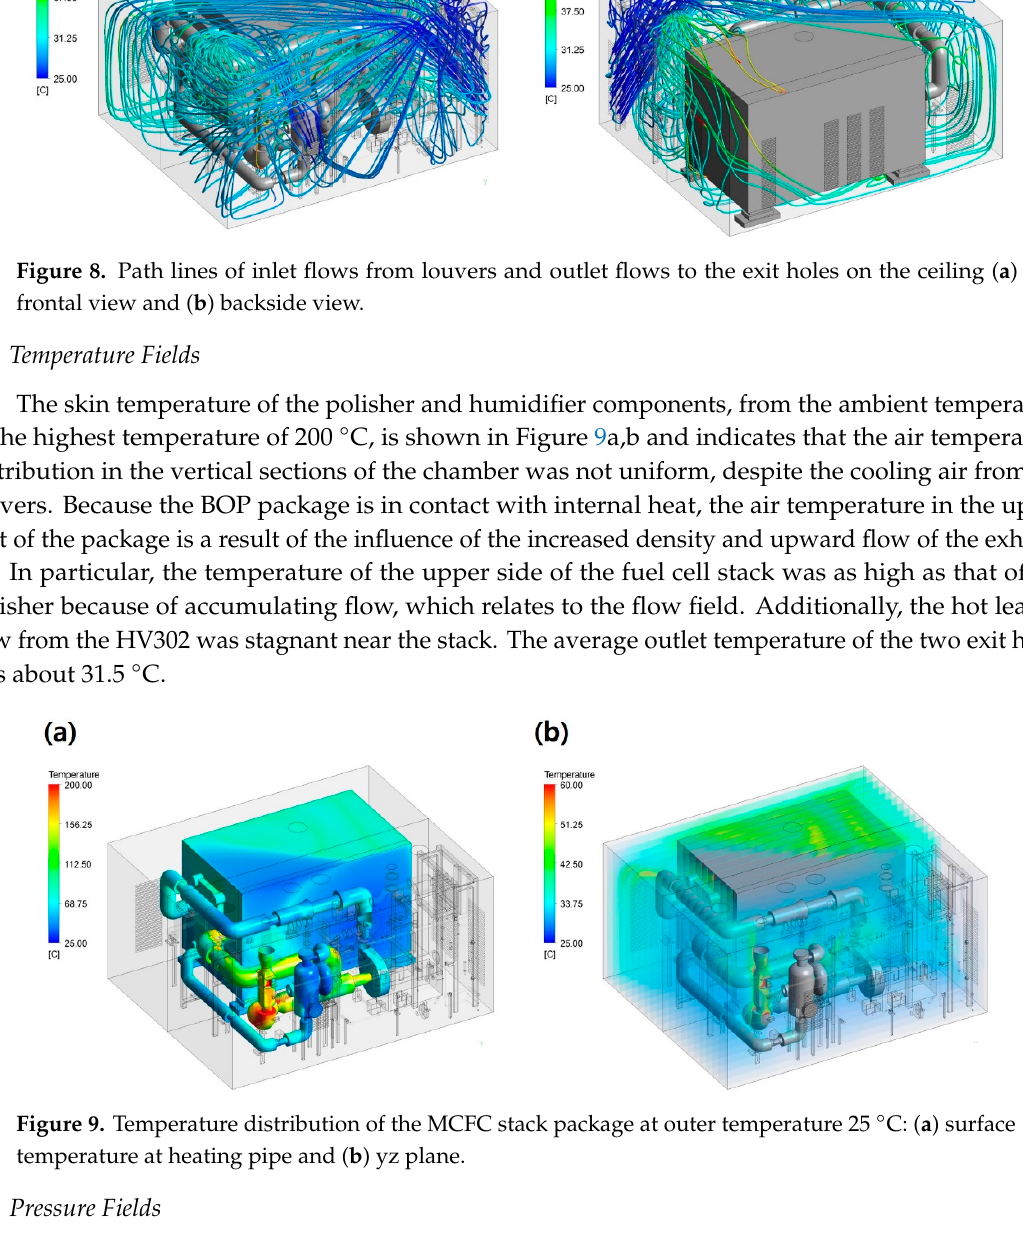
Figure 9. Temperature distribution of the MCFC stack package at outer temperature 25 °C: ( a ) surface temperature at heating pipe and ( b ) yz plane.